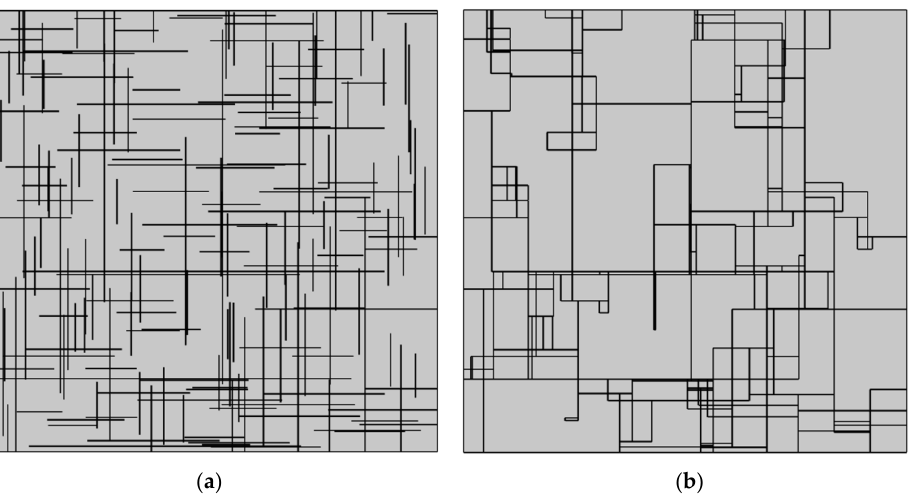
Figure 5. Fracture network: ( a ) original network ( b ) backbone network.